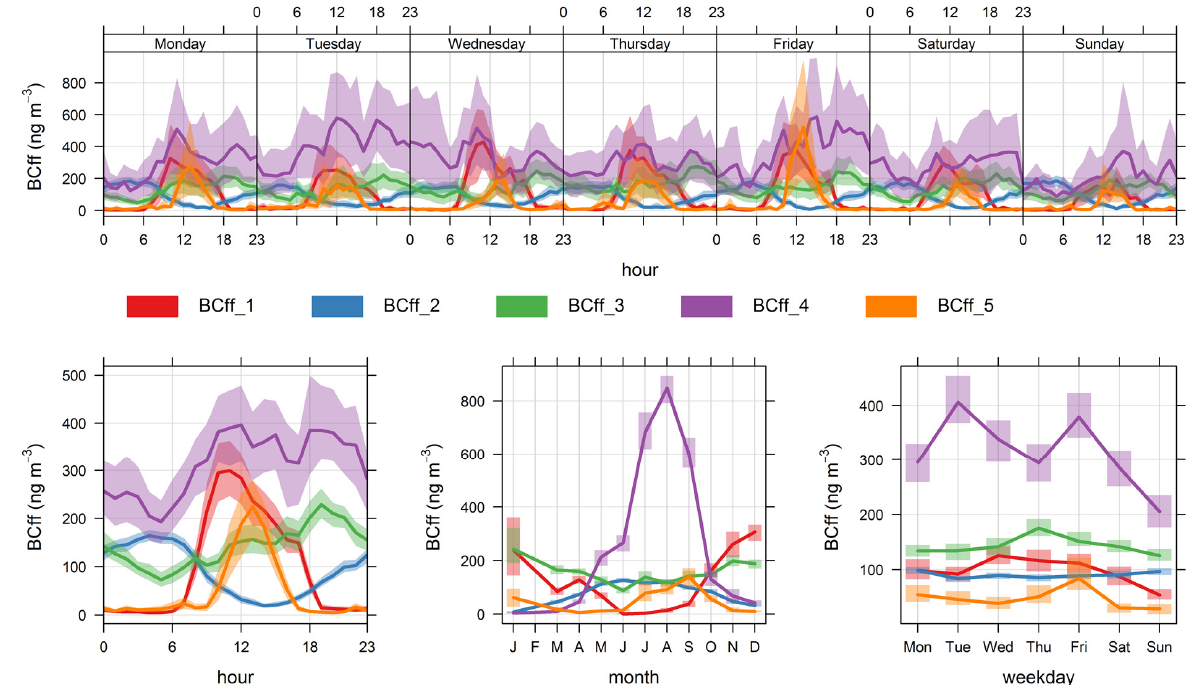
Figure 5. Time variability plot for the five fuzzy clusters' contributions to BC ff .